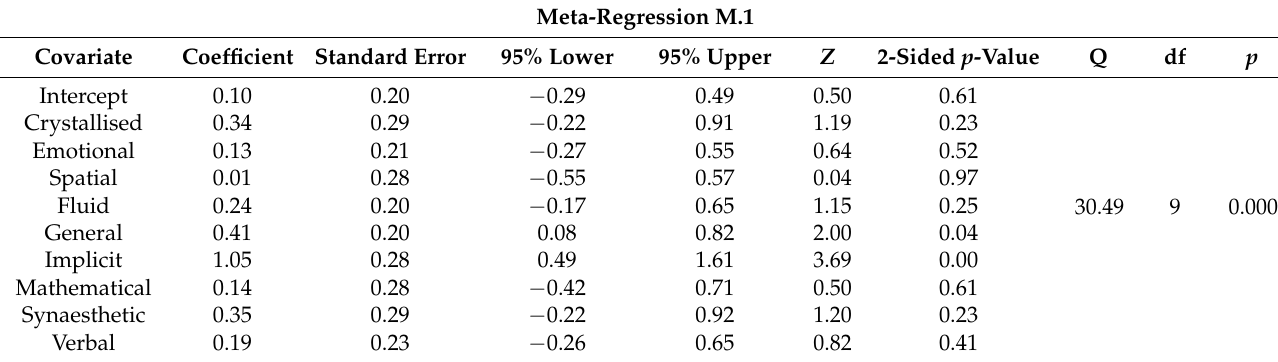
Table 3. Meta-regression of model 1: Intelligence. Meta-Regression